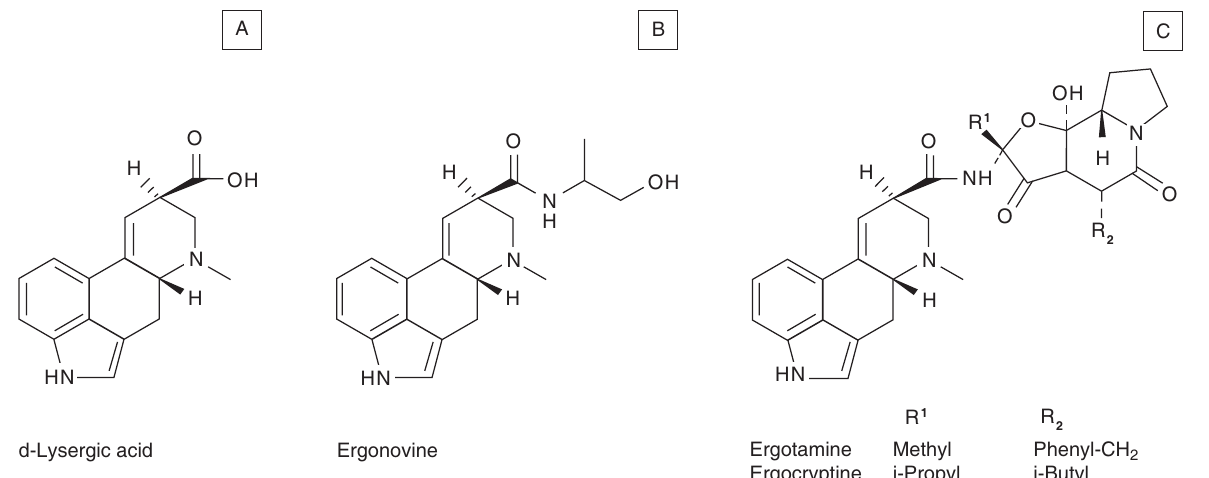
FIG. 1 The structures of (A) d-lysergic acid (B) ergonovine, a typical amide of the latter and (C) ergotamine and ergocryptine, typ- ical cyclol ergopeptine